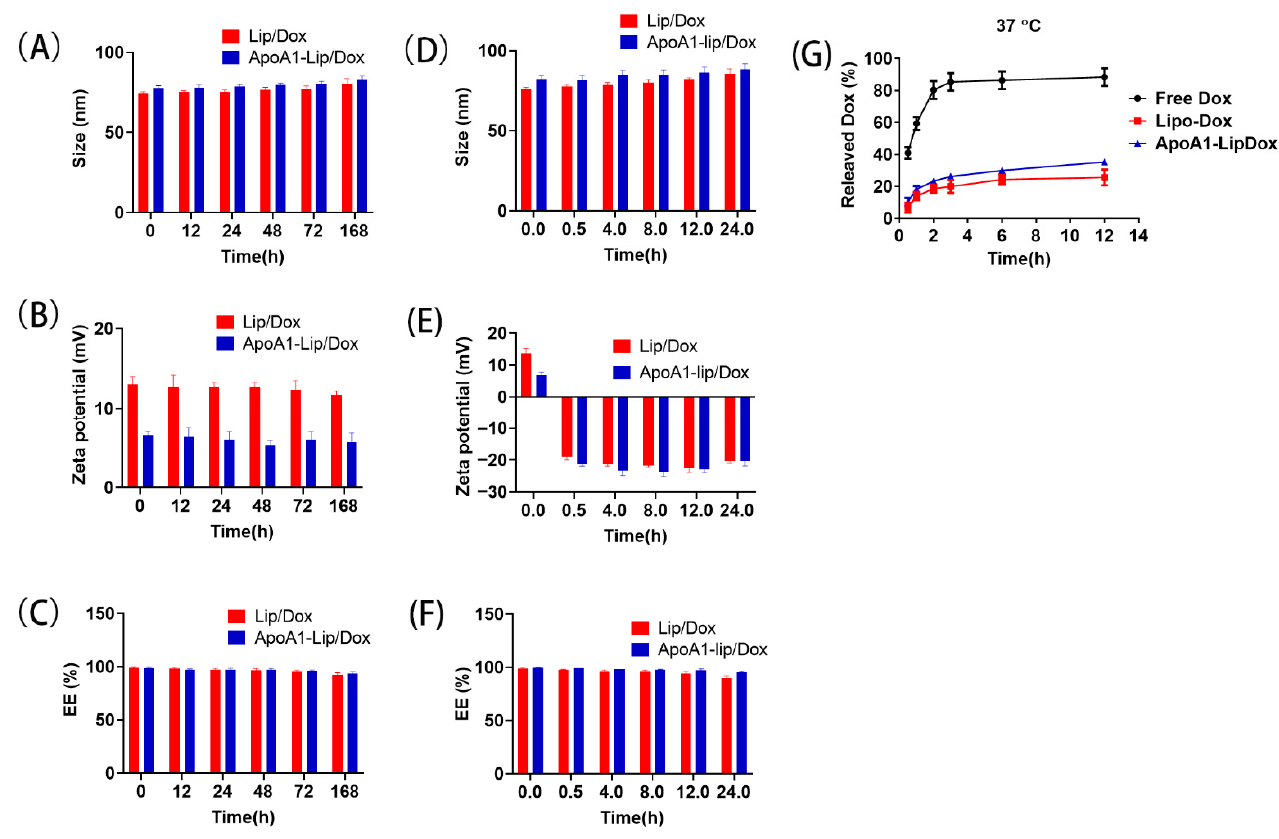
Figure 1. Size distribution ( A ) and observation by transmission electron microscopy ( B ) of Lip/Dox and ApoA1-lip/Dox.